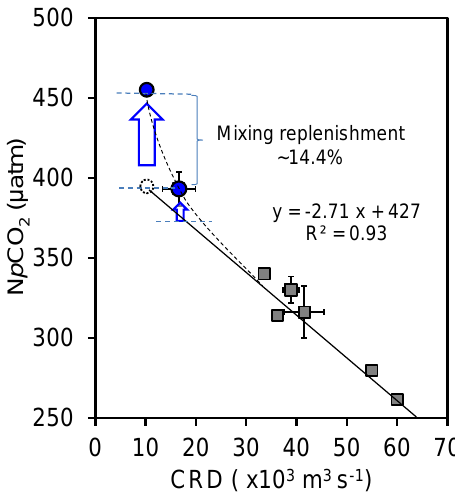
Figure 5. The correlation between monthly average N p CO 2 and CRD (black square) was observed during warm cruises from May to November between 1998 and 2011: observed N p CO 2 about 455.1µatm (blue dot) and the computed N p CO 2 397.7µatm (dotted circle) at the CRD at 10211m 3 s − 1 during the January